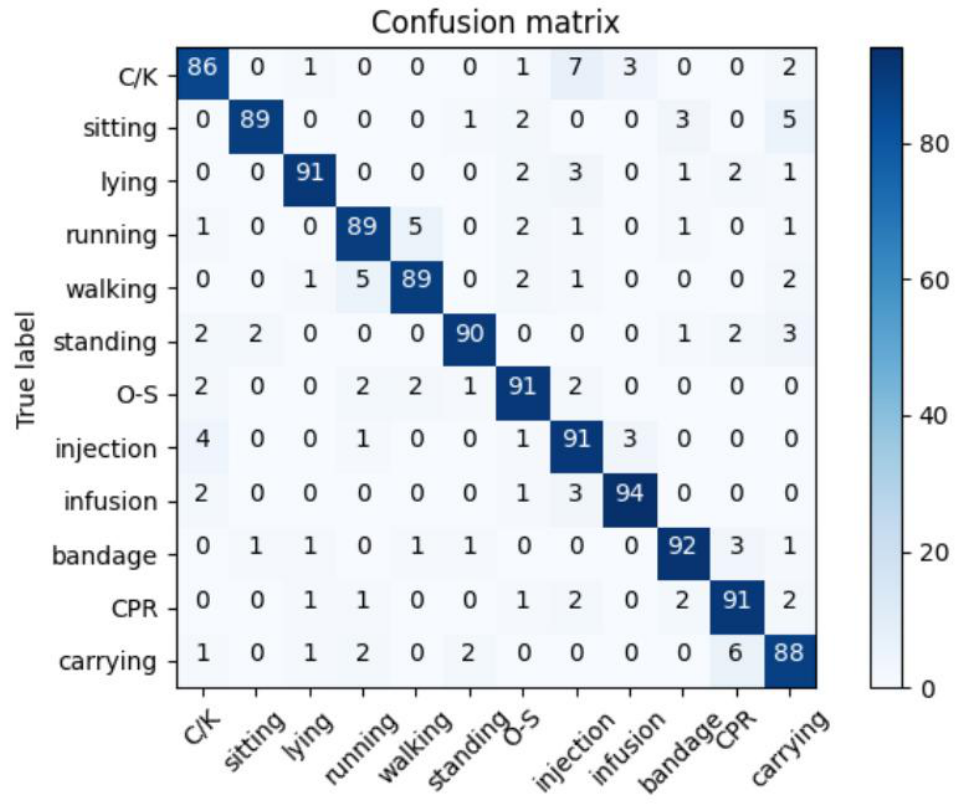
Figure 11. Confusion